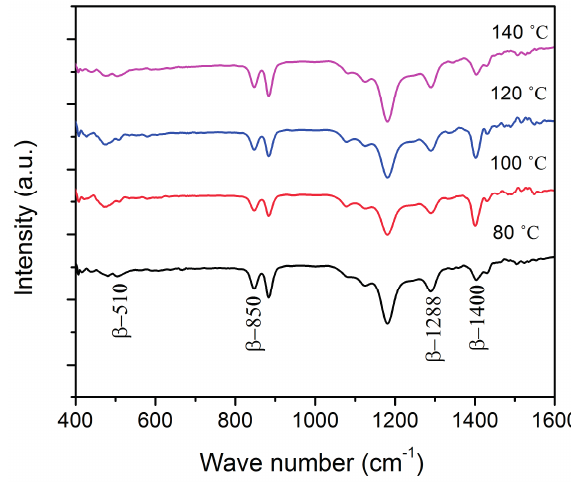
Figure 4. FTIR spectra of P(VDF-TrFE) thin films treated at different annealing